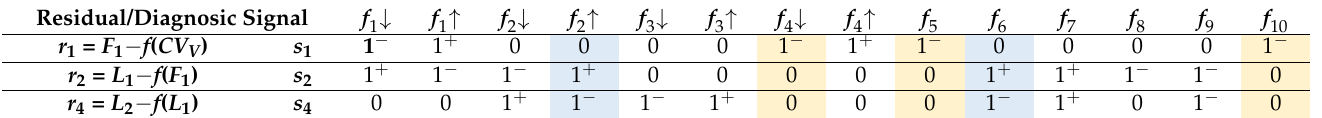
Table 5. The set of considered residuals and diagnostic matrix for process fault diagnosis. Residual/Diagnosic